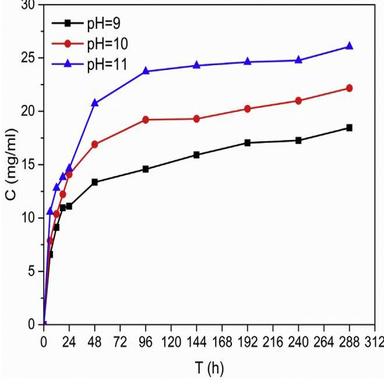
Influence of pH values on mineral dissolution.